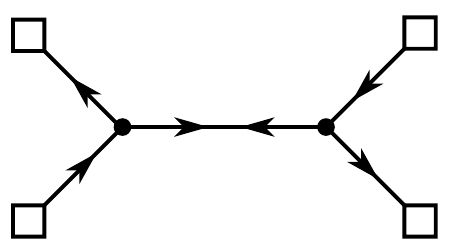
Figure 2 . Diagrammatic representation of the gauge theory corresponding to table